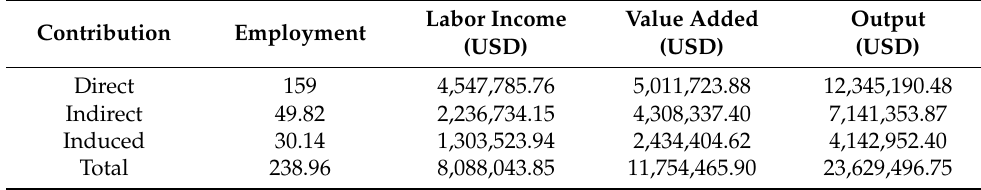
Table A11. Contribution of Partner Employment to Lee and Collier Counties (Annual).